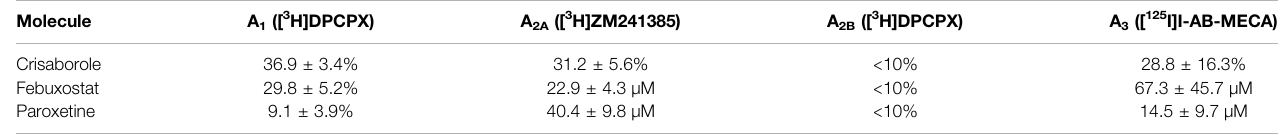
TABLE 1 | Inhibition of speci fi c binding at all four ARs (% inhibition at 100 µM of the radioligand shown, or K i (µM)). a Molecule A 1 ([ 3 H]DPCPX) Crisaborole